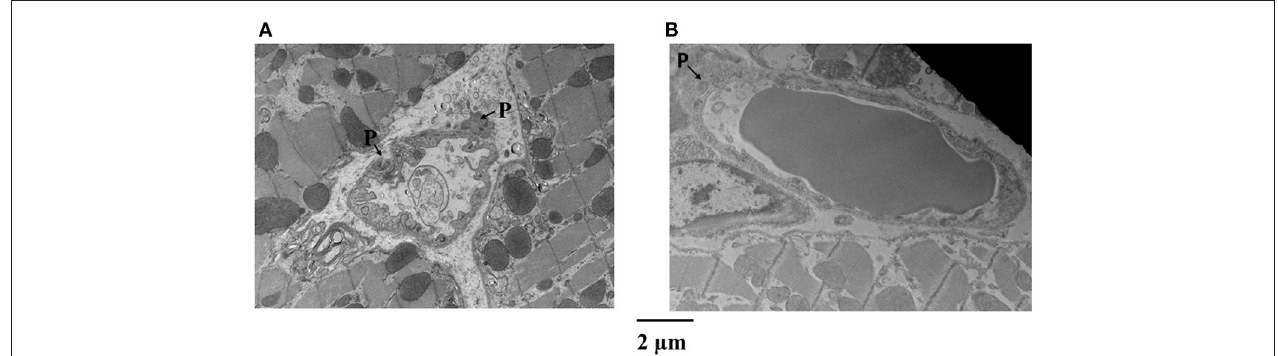
FIGURE 4 | Examples of capillaries and their relation with pericytes (P) from the epicardium of a dog where CDP dropped from 42 to 34 mmHg and MVR decreased in that bed from 1.14 to 0.94 mmHg (mL · min) − 1 when adenosine was infused. (A) Shows a capillary from the bed not receiving adenosine, while (B) depicts a capillary from the bed receiving adenosine. The capillary in (A) is surrounded by several pericytes and demonstrates many luminal invaginations. Not only the capillary diameter is smaller in (A) than in (B) but also the luminal surface is highly irregular.